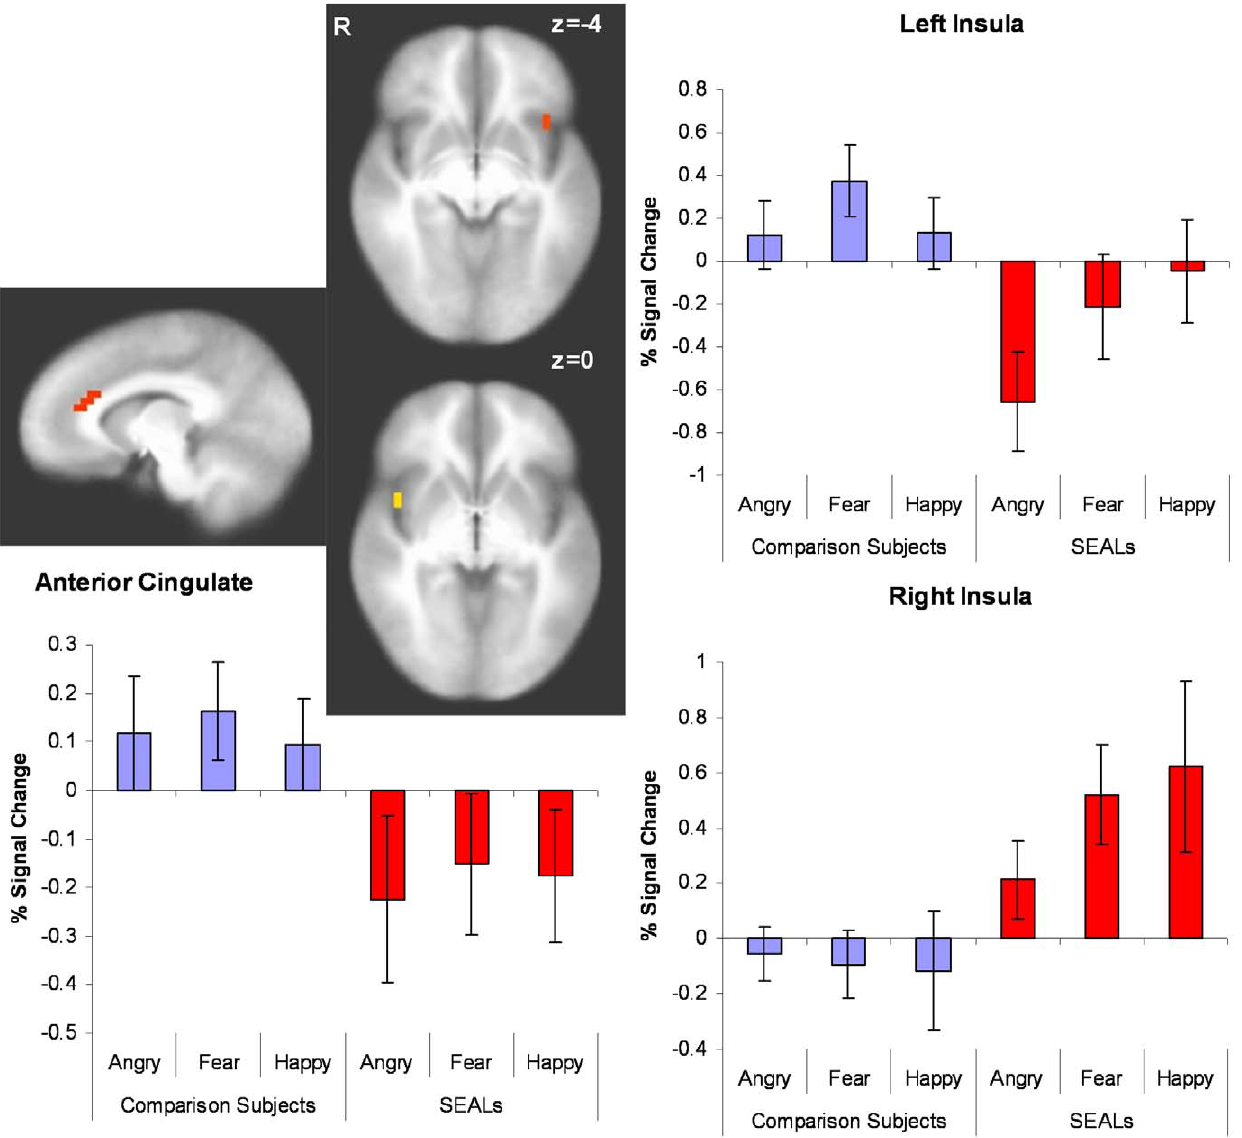
Figure 3. Group Differences Overall group differences showed relatively greater right insula activation in SEALs versus left insula activation in comparison subjects.